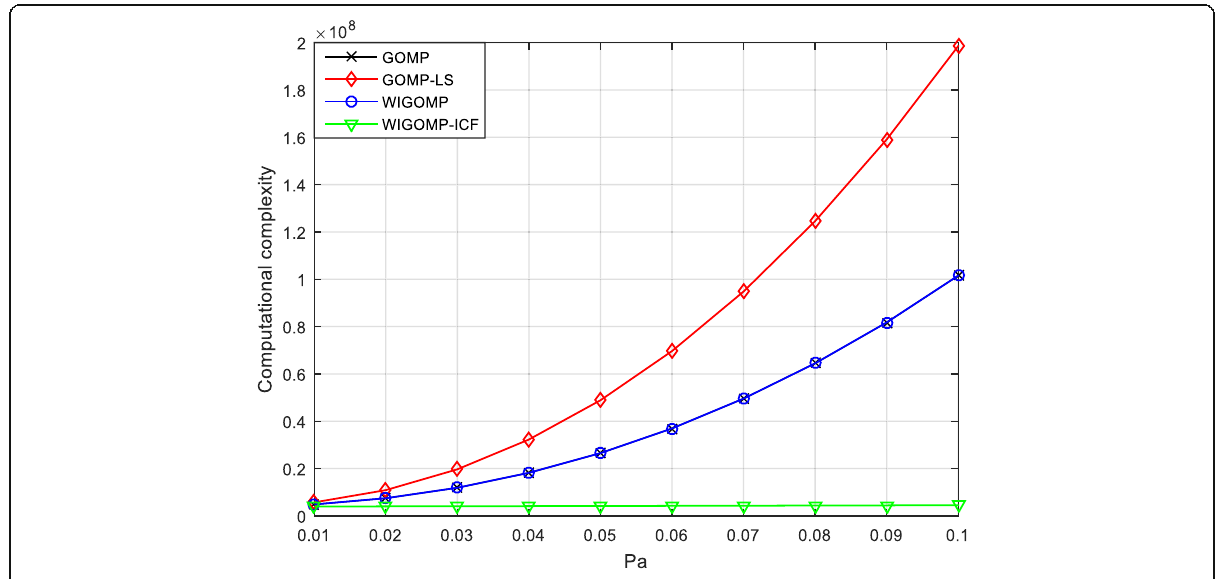
Fig. 8 Activity probability versus computational complexity, where K = 128, M = 32, N c = 120, v = 8, and β =